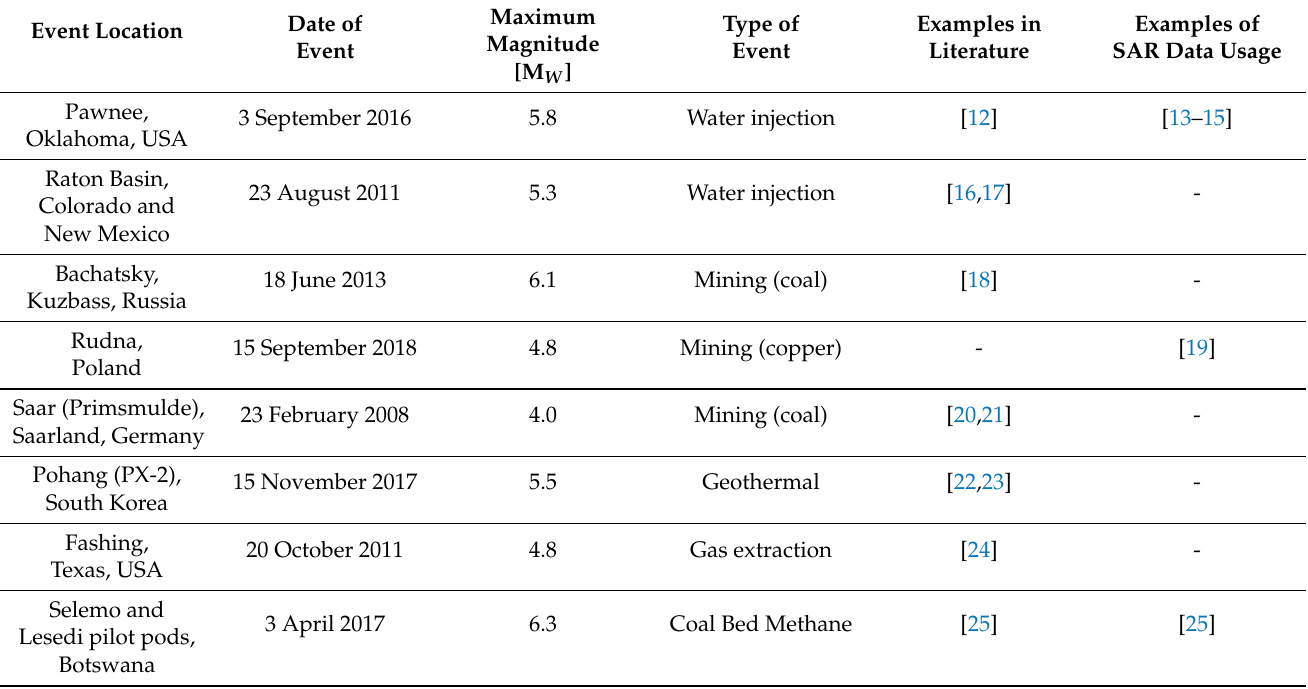
Table 1. Comparison of some induced seismic tremors around the world with regards to the type of exploitation. The table also includes examples of how synthetic aperture radar (SAR) data are used to facilitate the detection of ground surface changes due to induced seismic